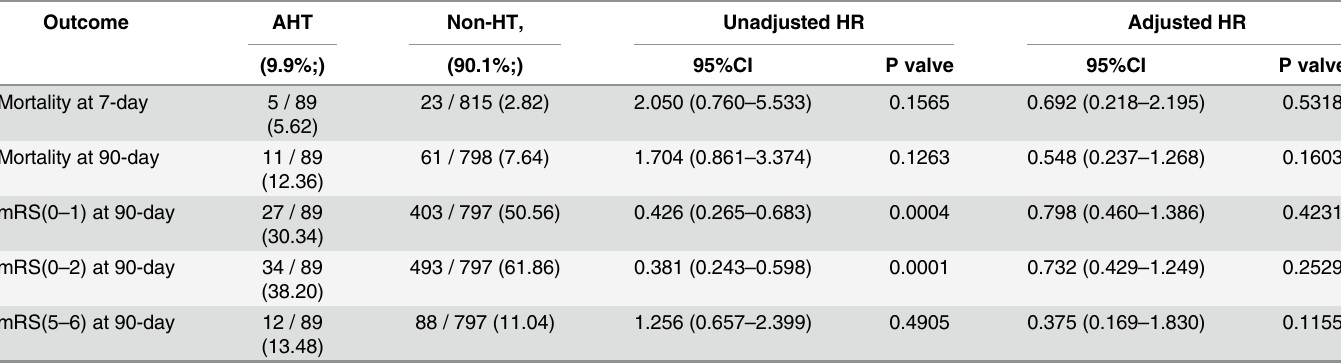
Table 2. Functional Outcomes between AHT and non-HT after thrombolysis.